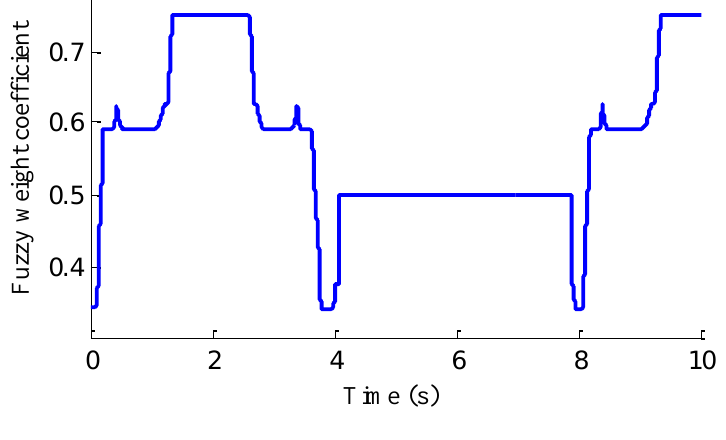
Figure 8. Fuzzy weight coefficient.